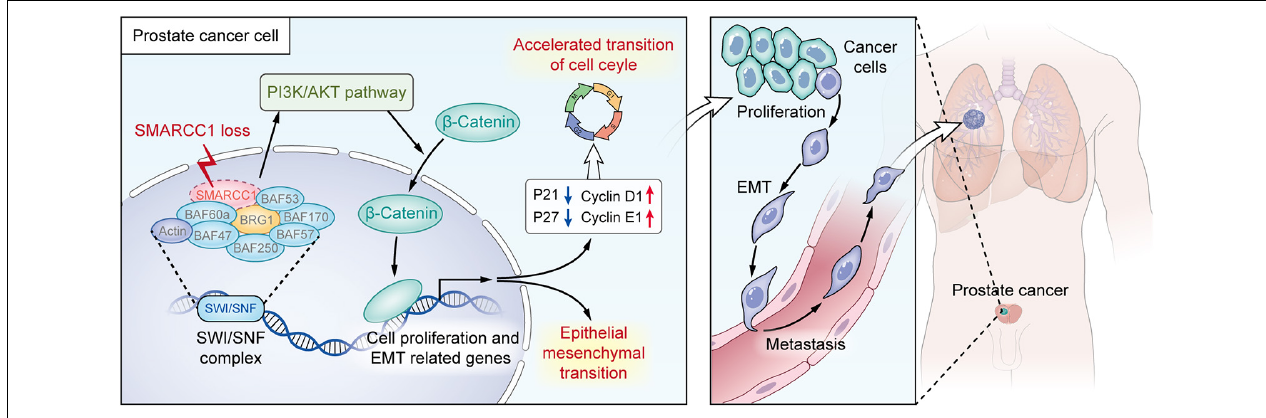
FIGURE 8 | Illustration for the pro-oncogenesis effect of SMARCC1 loss on PCa. SMARCC1 loss in PCa activates the PI3K/AKT pathway and induces the translocation of β -catenin to promote proliferation and epithelial mesenchymal